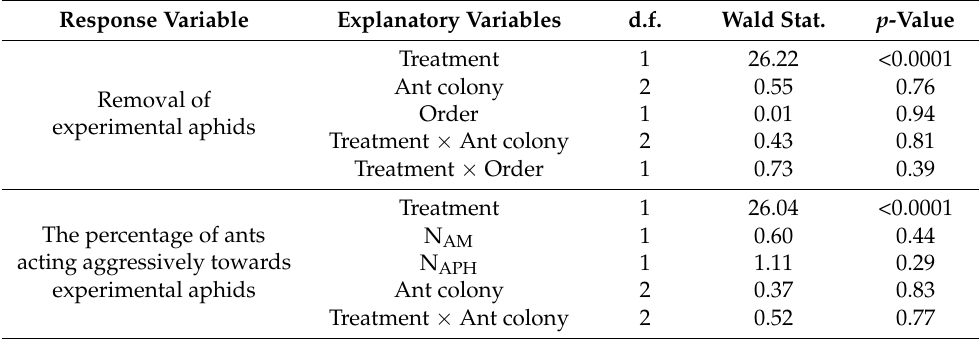
Table 1. Statistical analysis of the behaviour of Lasius fuliginosus milkers towards Chaitophorus pop- uleti experimental aphids contaminated with Beauveria bassiana (BB) or not (C). With a Generalized Linear Model (GLM), with binomial distribution, the association of aphid removal (aphid was re- moved or not) with treatment, ant colony ( n = 3), the presentation sequence of experimental aphids (order: 1 or 2) and the association of aggressive behaviour (ant encountering experimental aphid displayed aggressive reactions or not) with treatment, ant colony, the number of aphid milkers (N AM ) and aphid colony size ( N APH ) were analysed. The sign (×) indicates the interaction of two factors influencing ant behaviour.